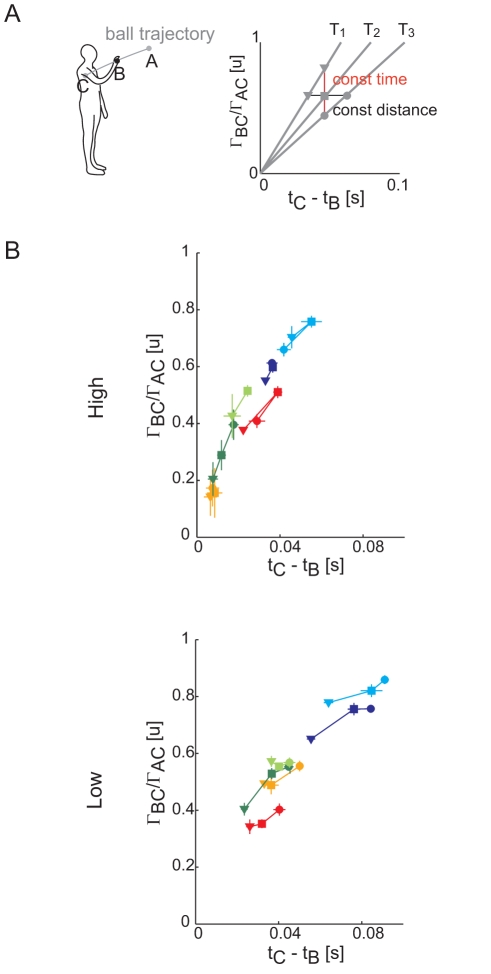
Interception point along the ball trajectory.(A) Left panel: schematic representation of the interception point index (computed as the ratio between the BC and AB ball trajectory arc lengths, see Methods). Right panel: for each flight time condition (T1–T3), subjects impact point along ball trajectory (normalized with respect to subject arm length) was uniquely determined by the movement time, hence the value of the difference between the extrapolated time of arrival of the ball at the frontal plane (tC) and the impact time (tB). However, for different flight times, subjects are free to vary tB and impact the ball at the same normalized distance (vertical line labeled “const distance”) or to catch the ball closer to their shoulder (horizontal line labeled “const time”). (B) Scatter plots of the interception index vs. tC−tB (mean ± SE across trials in the same conditions; SE are reported only when number of trials per block was larger than 2). A value of I = 0 indicates a catch at C while I = 1 indicates a catch in correspondence of the first possible interception point (A point), computed as the interception between the ball trajectory and the sphere centered at the shoulder joint of radius equal to arm length. It was not possible to determine S3 behavior in the T3Z2 condition because the shoulder marker detached and was missing throughout the entire block. Subject color coding as in Figures 2 and 3.